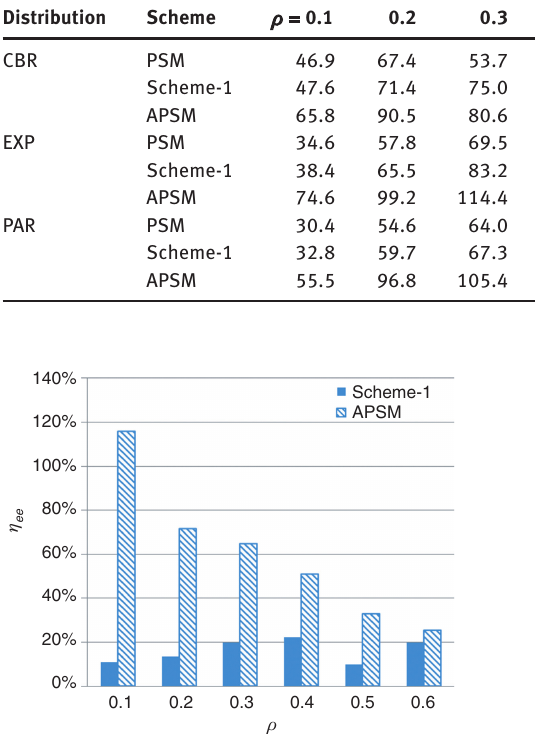
of the APSM and Scheme-1 Under EXP Traffic, When c = 3. Figure 3. η ee